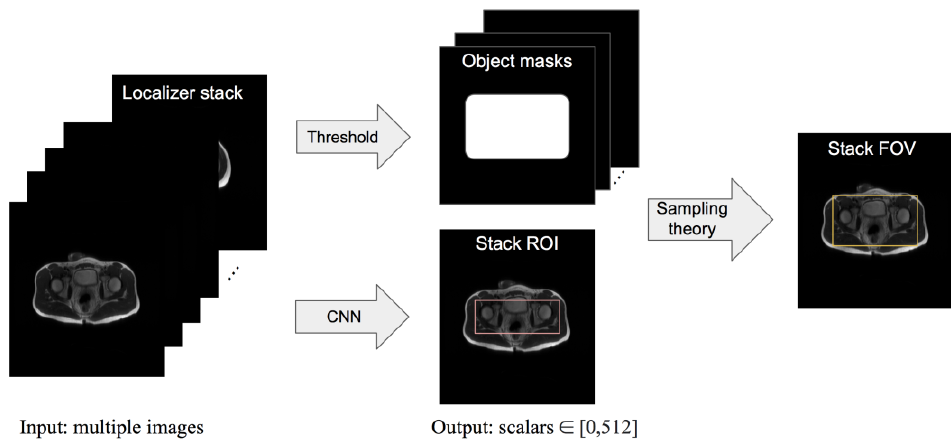
Figure 2. Overview of the proposed framework pipeline. First, a CNN-based model is trained to predict an ROI for a localizer stack. Then, slice-wise simplified rectangular masks of the object are obtained by setting a threshold on the row or column sums of the pixel values. The final output is the smallest FOV that places aliasing copies of the object masks outside the predicted ROI.